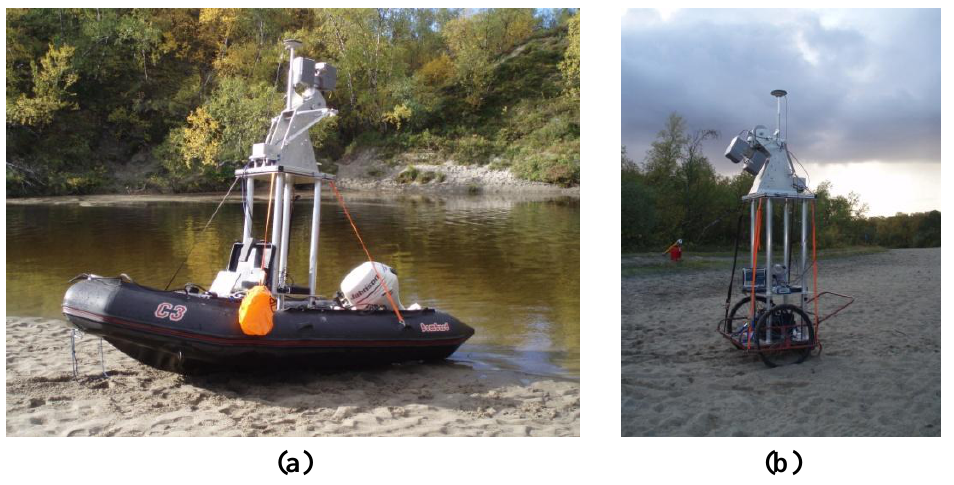
Figure 2. The mobile laser scanners used in the study: (a) the BoMMS and (b) the